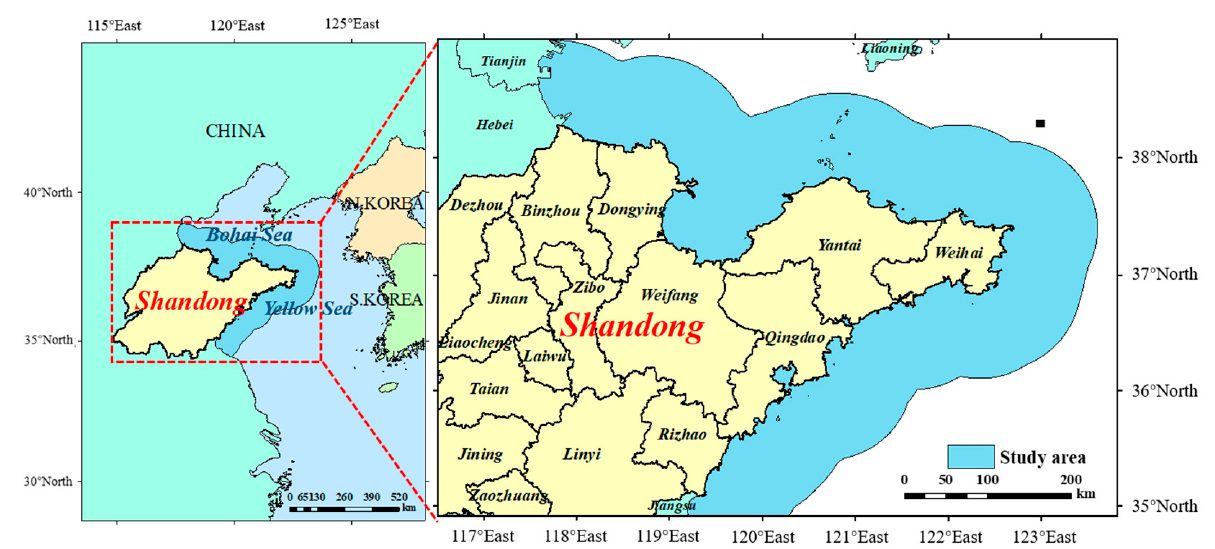
Figure 3. Study Figure 3. Study area. Table 2. Data descriptions and sources of criteria.